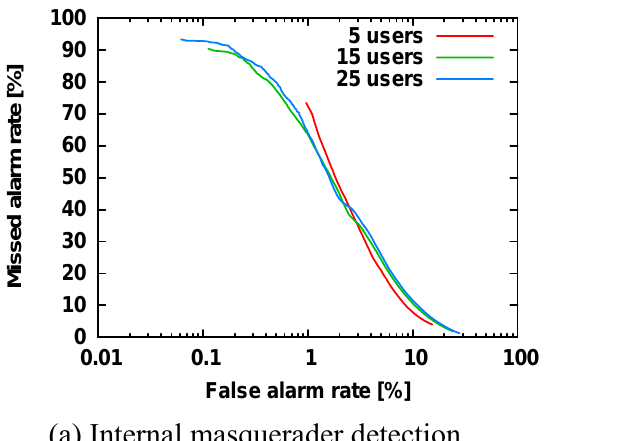
Figure 5. ROC curves for the detection of internal masqueraders (a) and external masqueraders (b) for N int = 5, 15 and 25 internal users. All other parameters are the same as those in Figure 3. The horizontal axis is a logarithmic scale, so we can focus on the missed alarm rate at the low false alarm